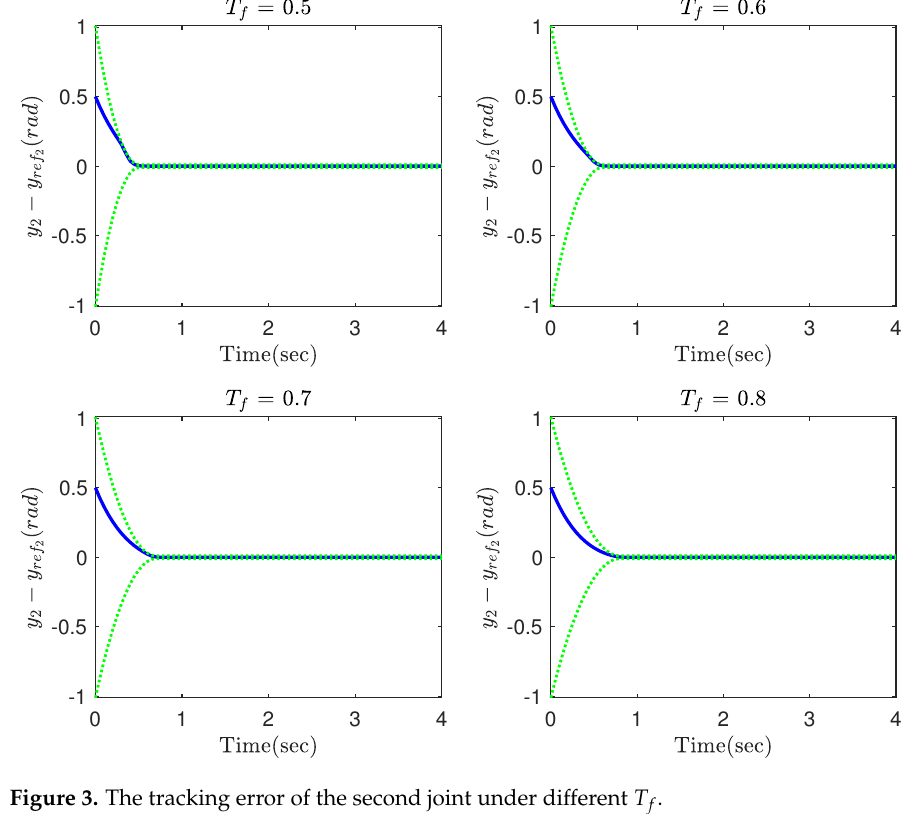
Figure 3. The tracking error of the second joint under different T f .